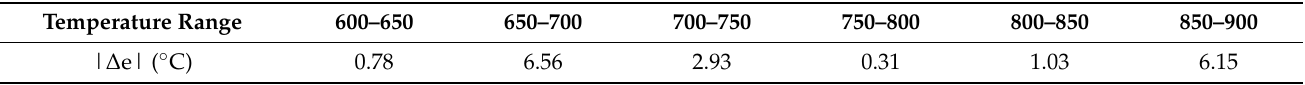
Table 1. A comparison of temperature measurement by patch antenna sensor and thermocouple.